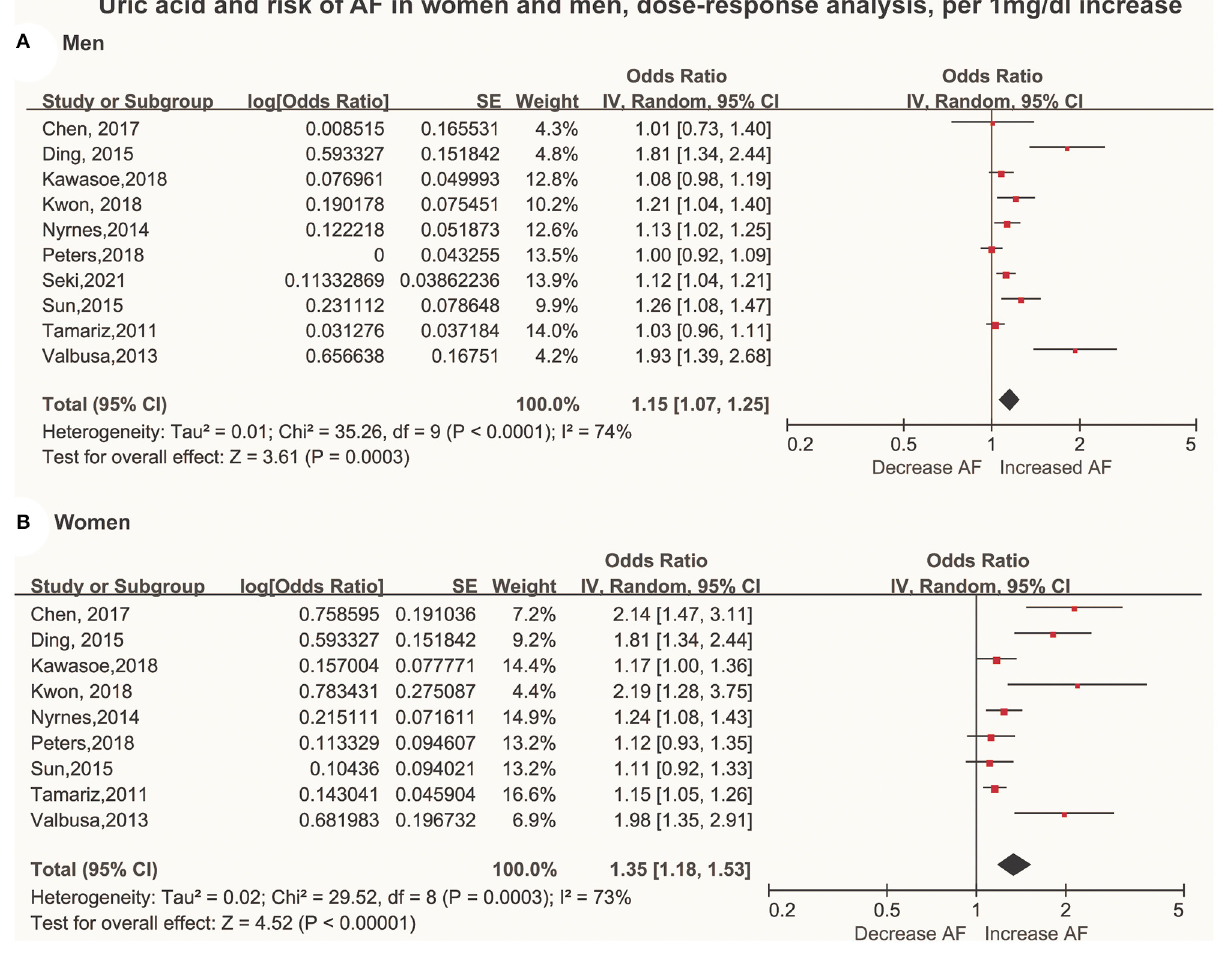
FIGURE 3 | Forest plot of the dose-response association between serum uric acid levels and AF among men (A) and women (B) . Serum uric acid was analyzed as per a 60 µ mol/L (1 mg/dL) increase. AF, atrial fibrillation SE, standard